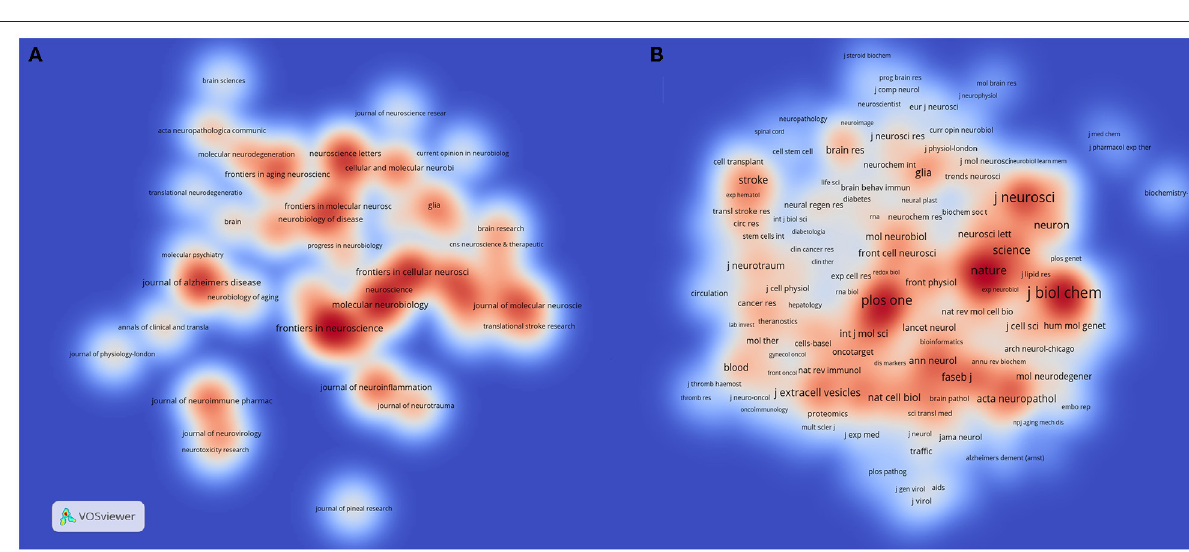
miRNA dysregulation (36). Moreover, activated microglia were able to facilitate the transmission of α -synuclein which was a central component for the pathogenesis of Parkinson’s disease (37). As for cluster 4, terms around extracellular vesicles were key research topics in the diagnosis and treatment of Alzheimer’s